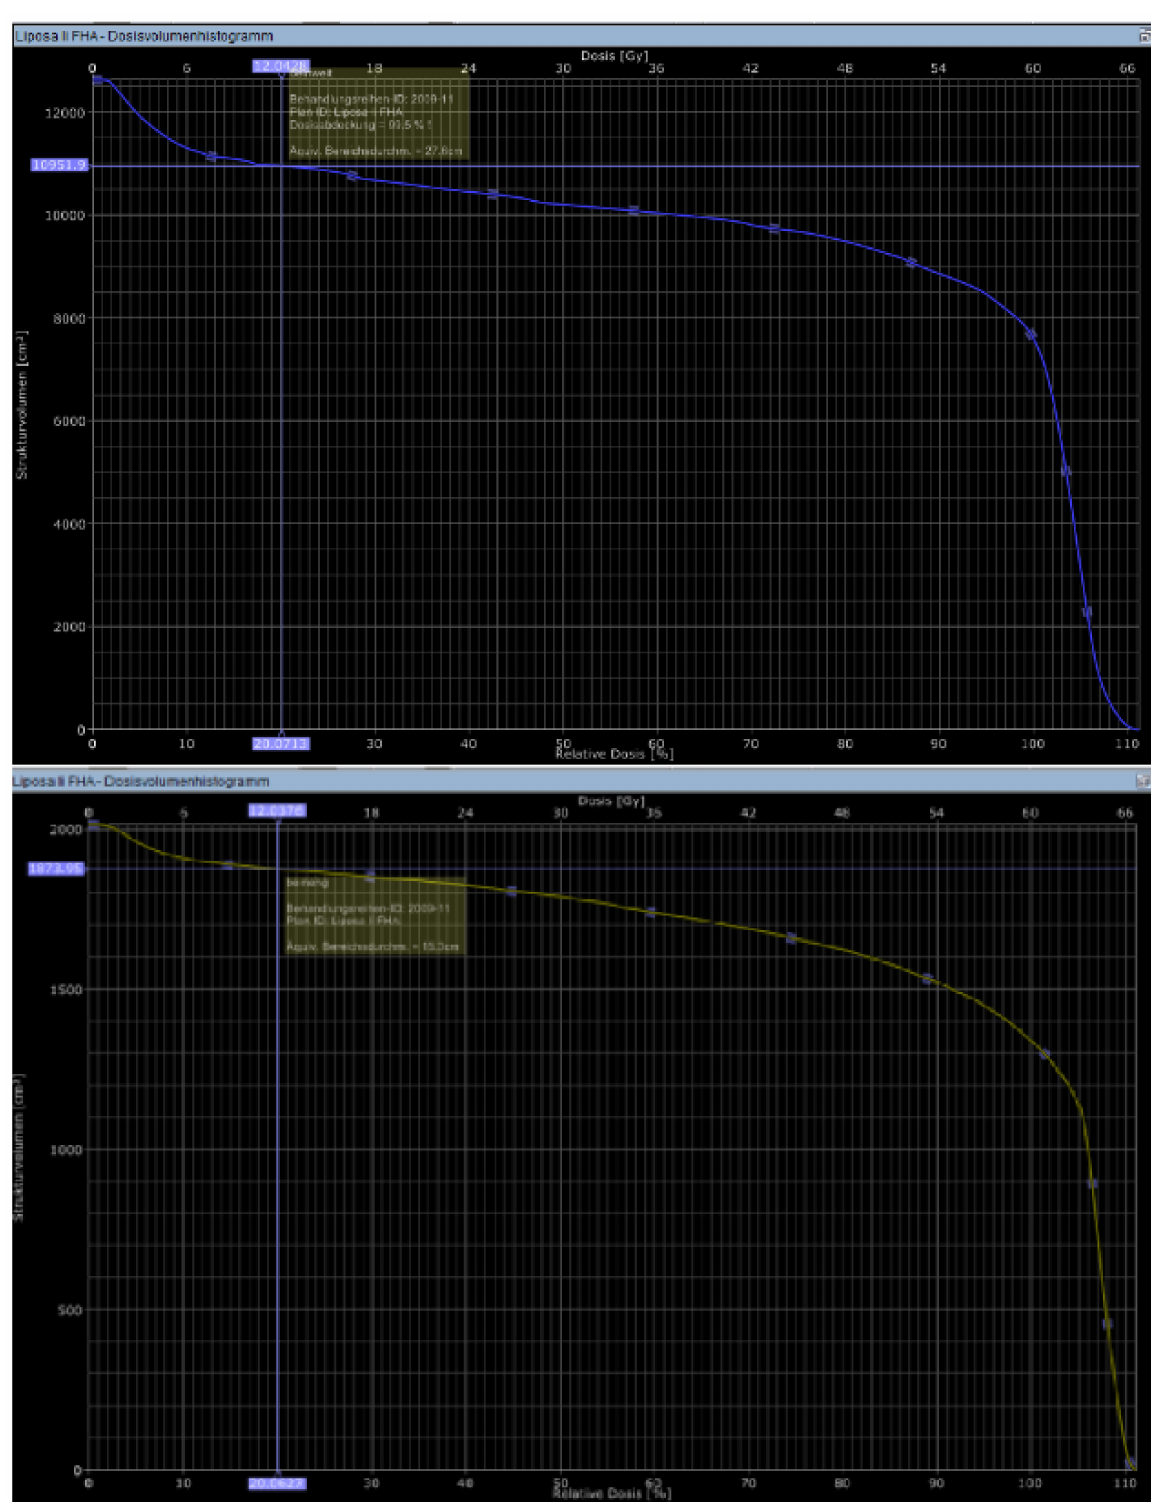
Figure 6. Calculating the volume receiving 20% of the dose in DVH (LSV) in the whole extremity (blue) and the narrowest part of the lymph-sparing volume